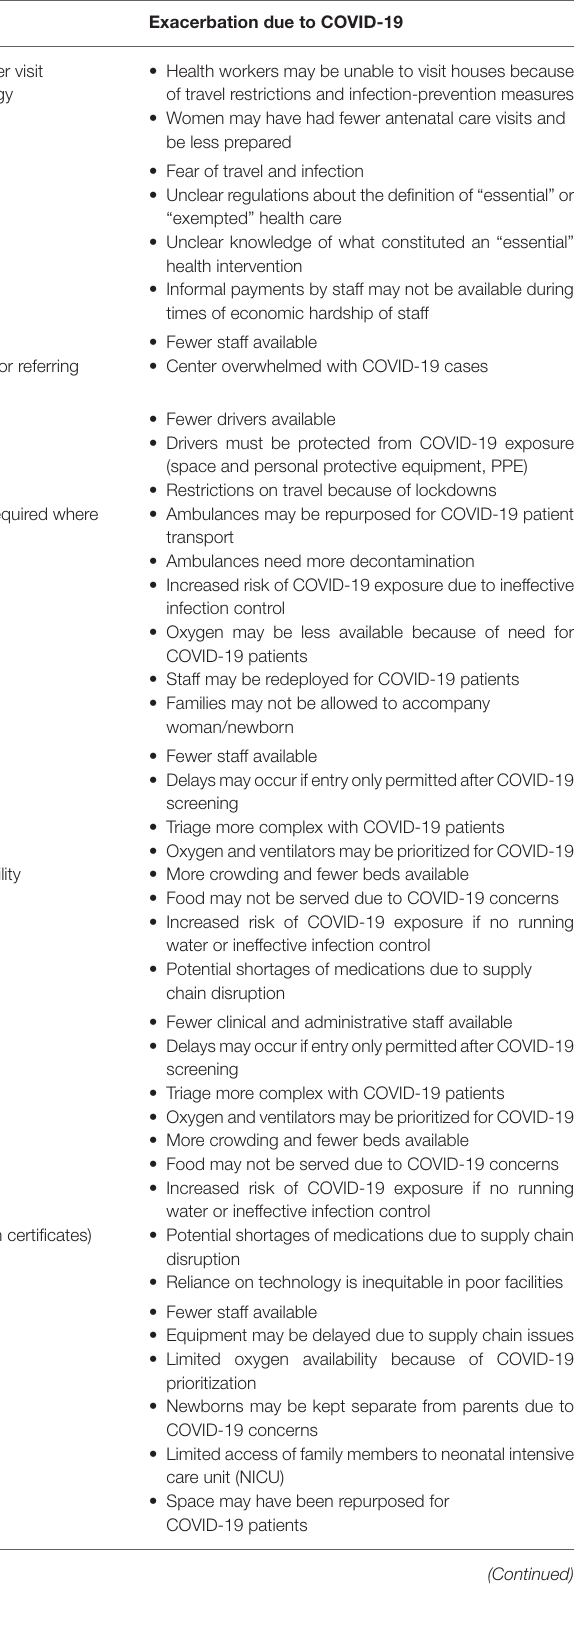
TABLE 1 | Facets and functions of the transport and referral system in maternal and newborn care (potentially exacerbated by the COVID-19 pandemic).